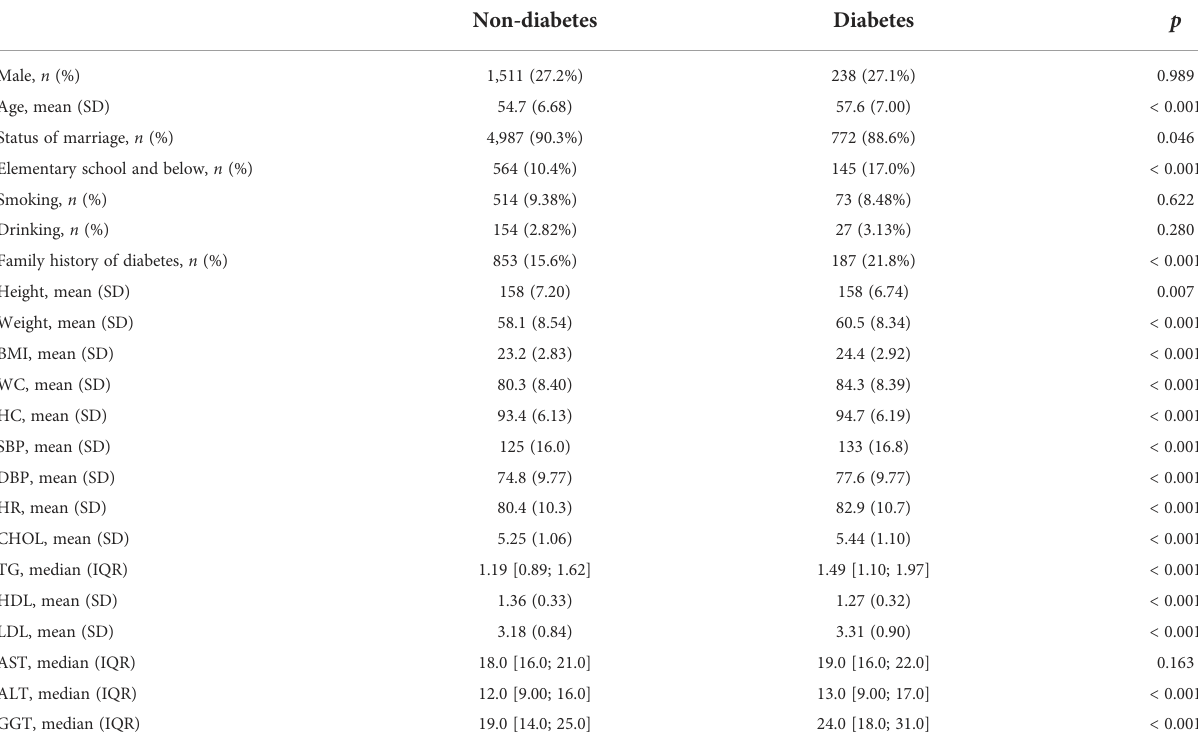
TABLE 1 Characteristics of the study